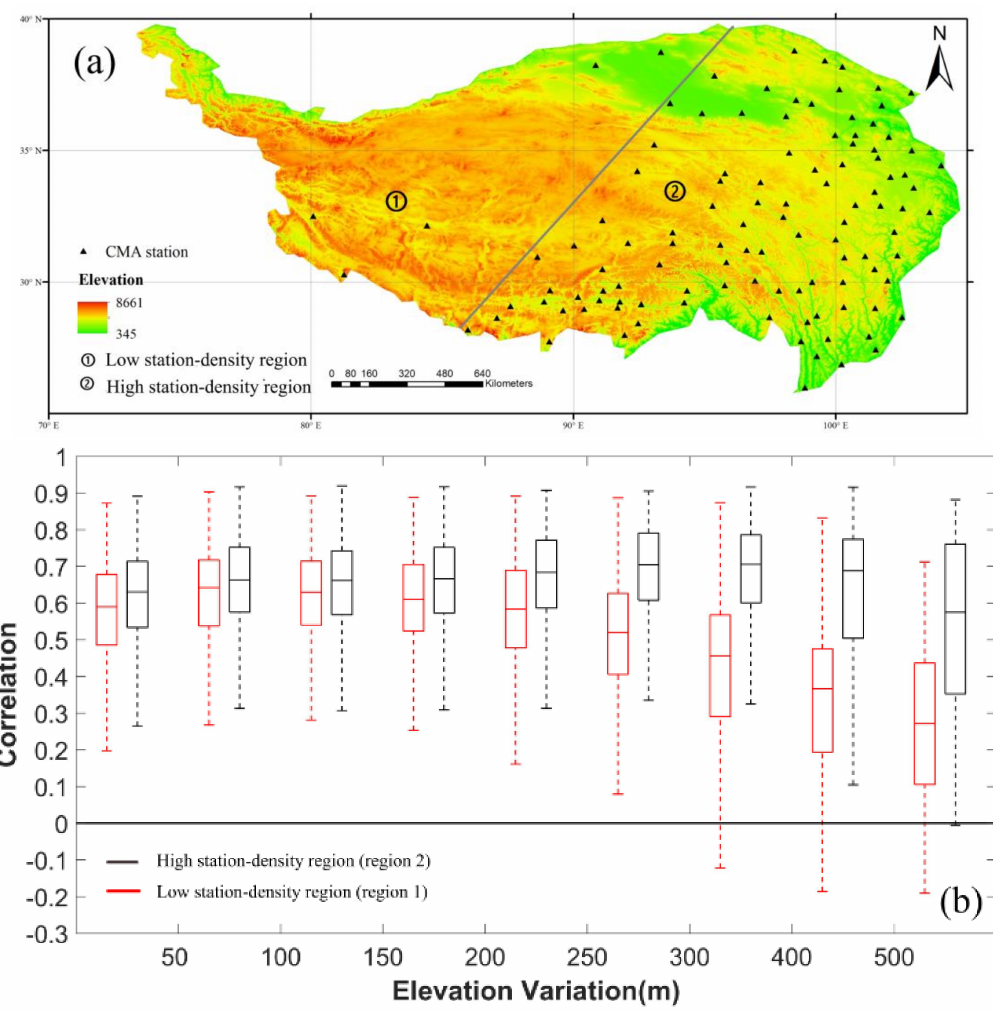
Figure 8. ( a ) China Meteorological Administration (CMA) operational stations that contributed observations to the China Meteorological Forcing Dataset (CMFD) dataset on the T. The TP is divided into two regions with high (Region 2) and low (Region 1) station densities. ( b ) Box-and-whisker plots of correlations between the SMAP L3_SM_P_E product and CLM simulations across different sub-grid elevation variance bins for Region 1 (red) and Region 2